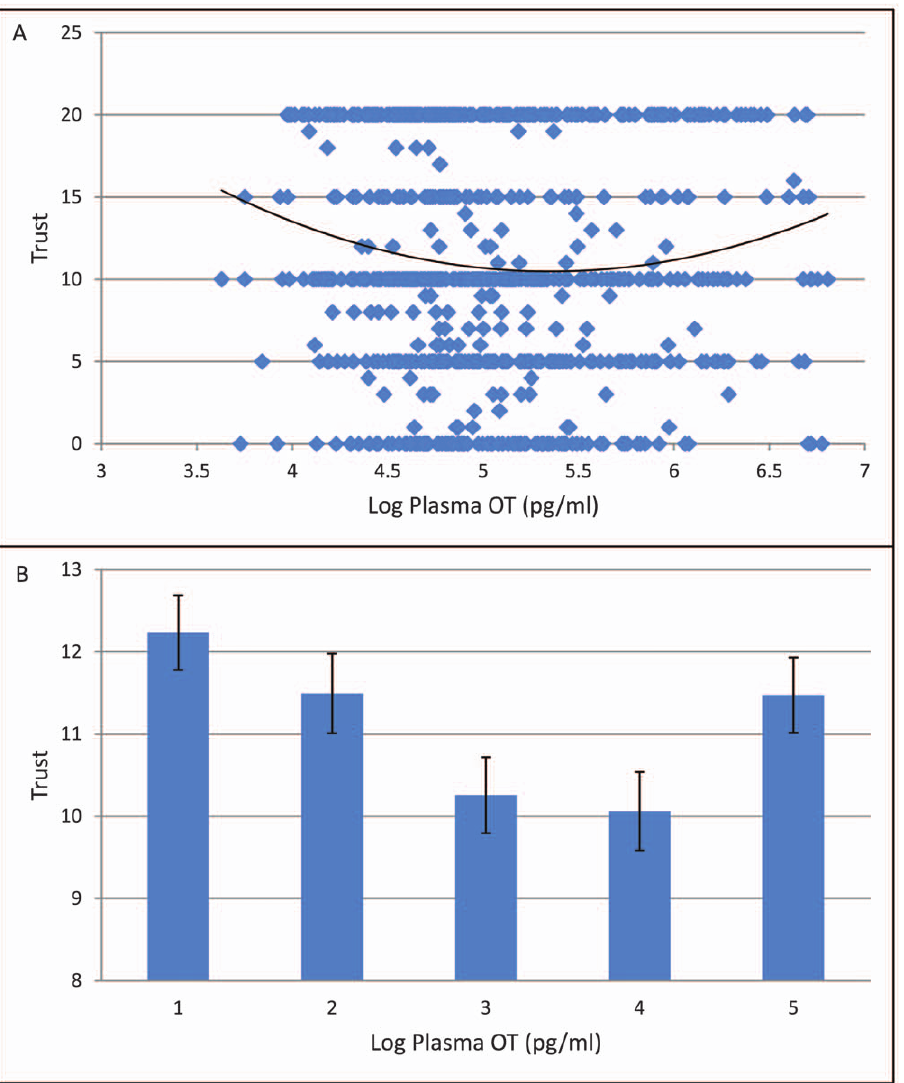
Figure 1. Plasma oxytocin and trust. (A) Scatter Plot on the relationship between plasma oxytocin and trust. (B) Histogram on the relationship between plasma oxytocin and trust.